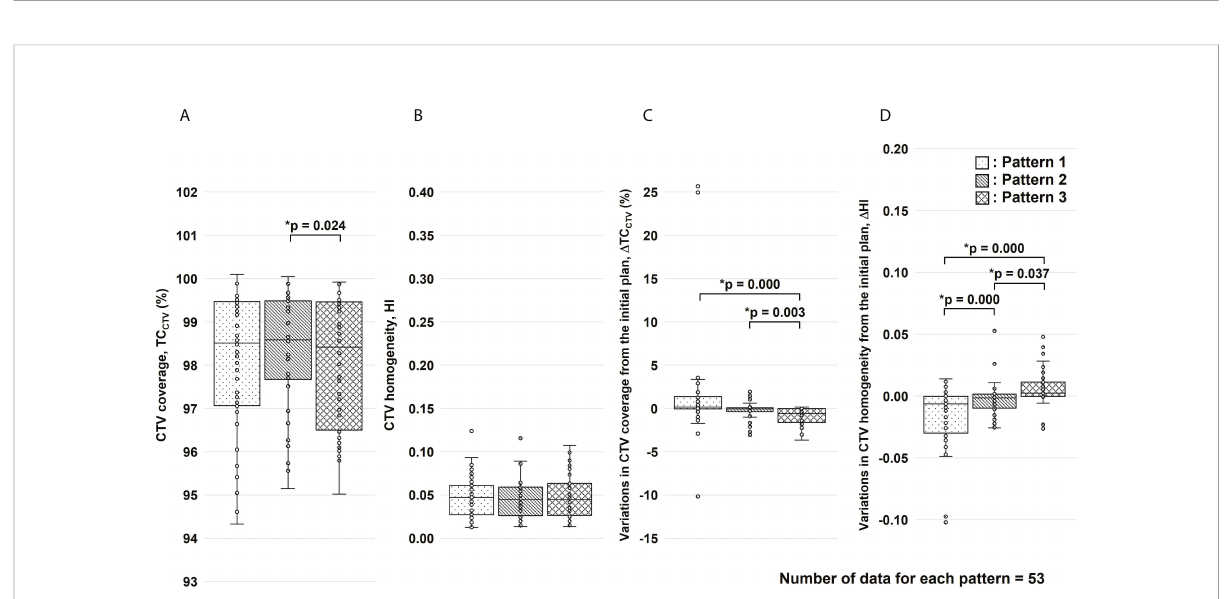
FIGURE 7 Results of the clinical target volume (CTV) coverage (TC CTV ) and homogeneity index (HI) evaluation for the total dose. Figure panels (A, B) show the results of TC CTV and HI, respectively. Figure panels (C, D) show the results of variations in TC CTV ( D TC CTV ) and HI ( D HI) from the initial plan, respectively. These results were corrected for changes in factors other than gastrointestinal gas. For each replacement pattern, the median, fi rst and third quartiles, maximum and minimum values, and outliers for (A) TC CTV , (B) HI, (C) D TC CTV , and (D) D HI are presented in a box-and-whisker plot. Statistical analyses were performed using the Friedman test. The symbol * indicate that there is a signi fi cant difference between them.